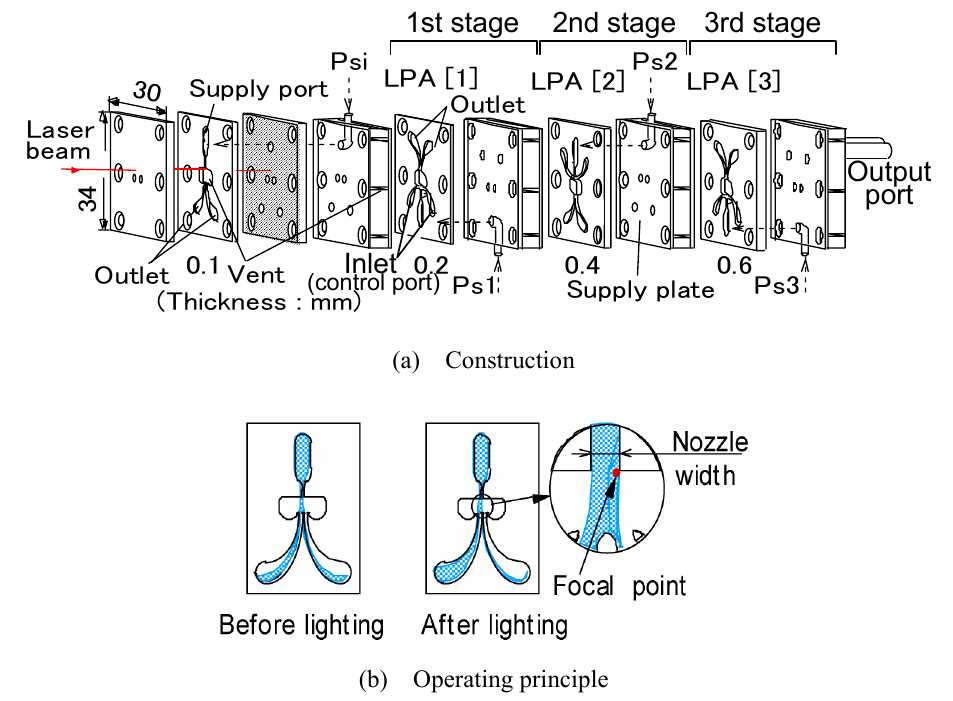
Construction and operating principle of photo-fluidic